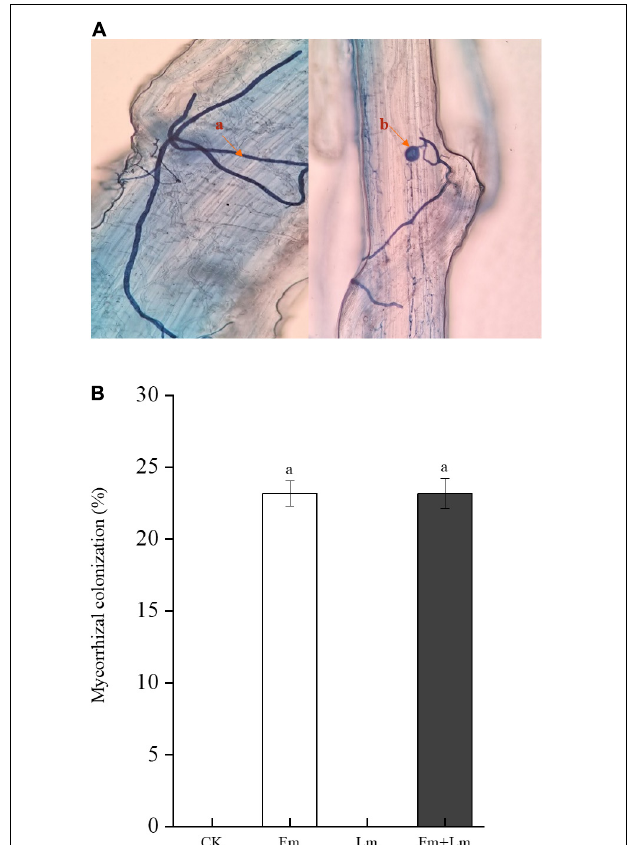
FIGURE 1 | The mycorrhizal colonization structure of AMF observed under 40 × magnification after (A) the root segments of E. nutans were stained with trypan blue (B) (0.05%, w/v) and the percentage of root mycorrhizal colonization in plants. The four treatments were (1) CK: no inoculation; (2) Fm: inoculated with F. mosseae only; (3) Lm: feeding with L. migratoria only; (4) Fm + Lm: inoculated with F. mosseae and L. migratoria feeding. (a) Internal hyphae; (b)